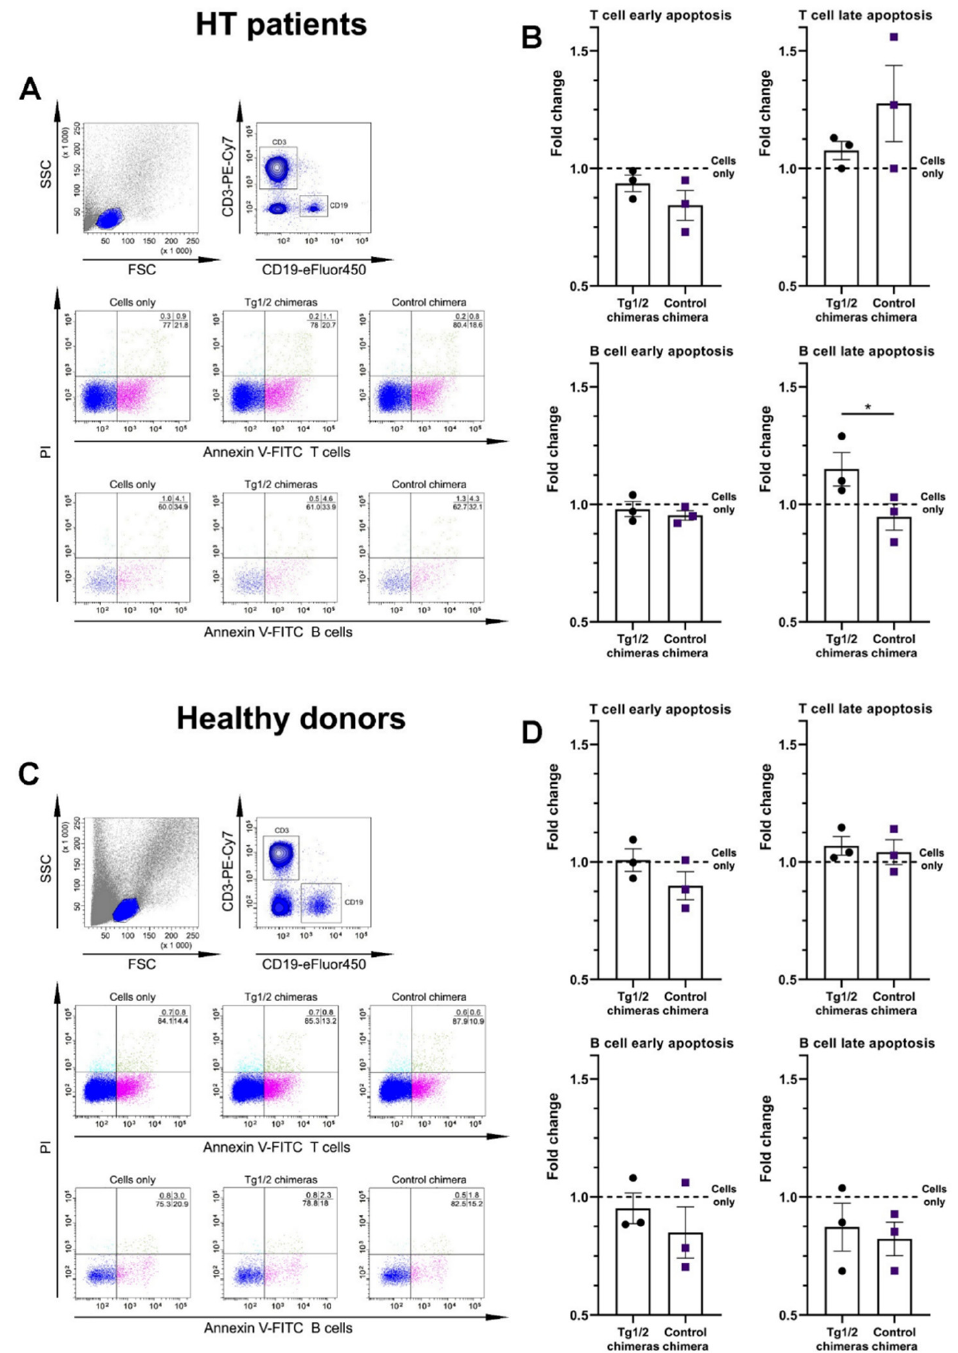
Figure 6. Tg 1/2 chimeras increase B-cell apoptosis. Isolated PBMCs from HT patients and healthy donors were co-cultured with 8 ng/mL Tg1/2 chimeras, or with Control chimera, or cultured in medium alone for 2 days, after which the cells were stained by Annexin V-FITC/PI and analyzed by FACS. The percentage positive cells within gated T or B lymphocytes are presented as plot graphs change of the early or late apoptosis of CD19+ and CD3+ lymphocytes are presented